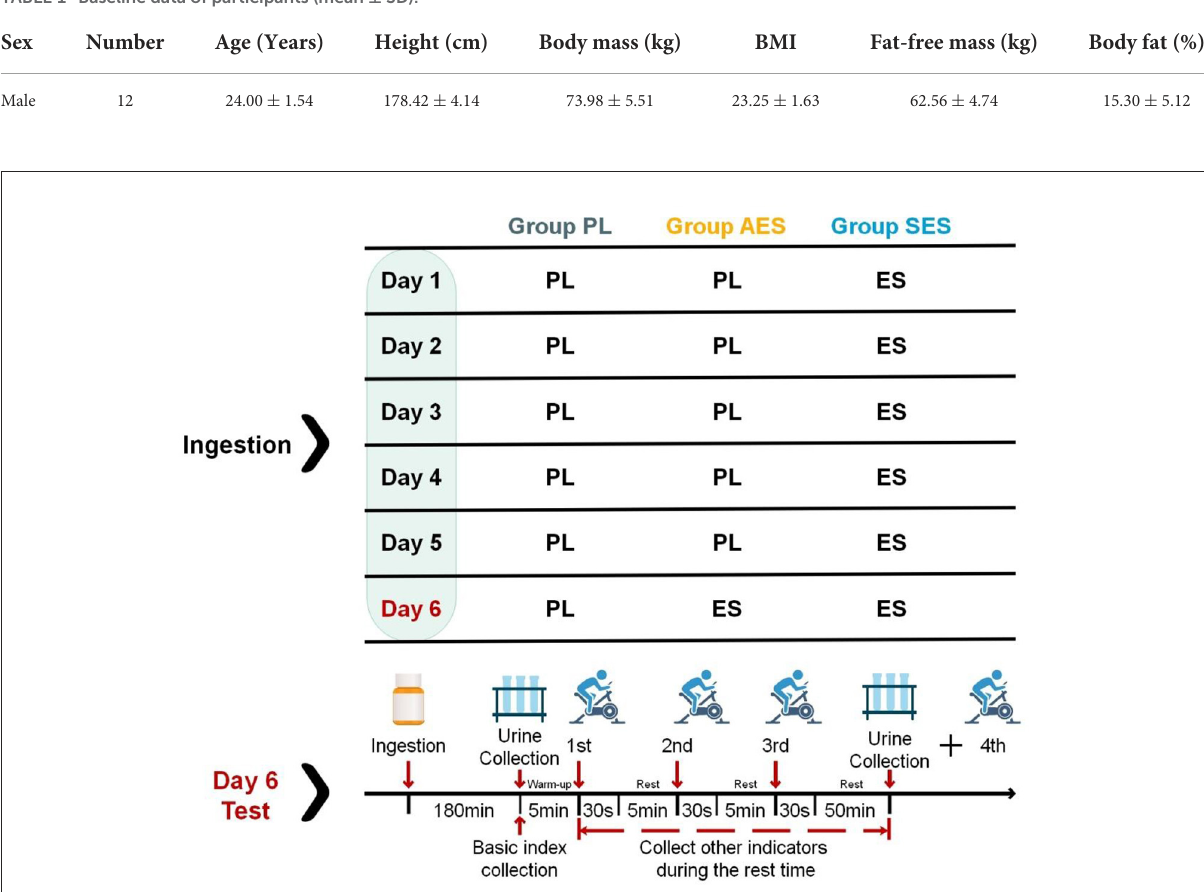
TABLE 1 Baseline data of participants (mean ± SD).